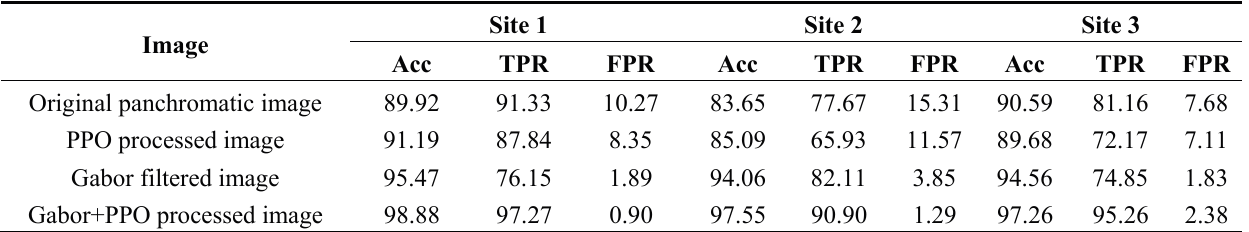
Table 1. Performance evaluation of the classification images when one global threshold (value: mean + 0.5 std) is applied to the original panchromatic image, the PPO processed image, the Gabor filtered image, and the Gabor + PPO processed (the proposed method) image, compared with the manual digitization for the Sites 1–3 in the Yukon image.